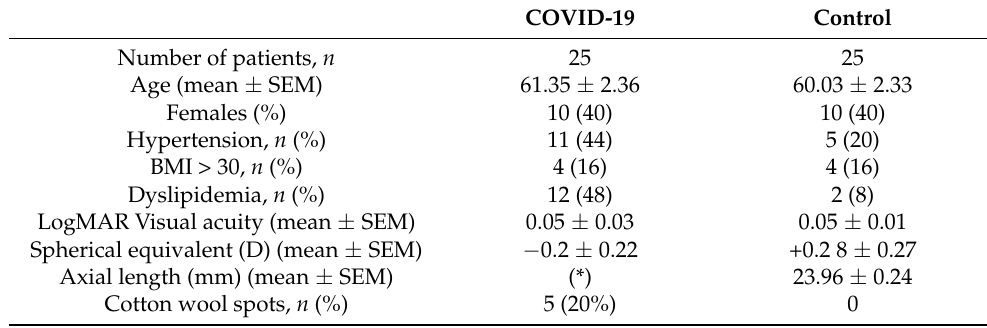
Table 1. Demographic, ocular, and systemic characteristics of the study population. (* not performed as per recommended protective measures during pandemic peak).